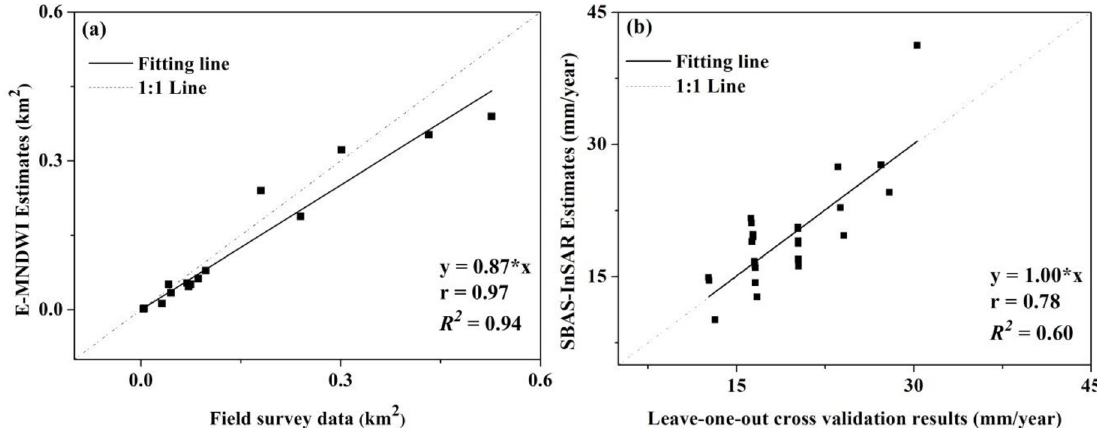
Fig 3. Agreement between observed and estimated underwater subsidence areas (a) and dry ground subsidence rates (b). Black solid lines are the fitting results, and grey dash ones are the 1:1